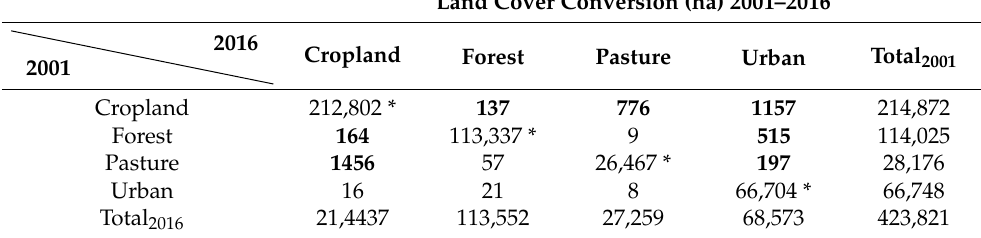
Table 2. Pivot table showing the land cover conversion (ha) of each cover type during the period 2001– 2016 across the Kalamazoo River Watershed. Bold values indicate the main land cover conversions, while “*” indicates no land cover